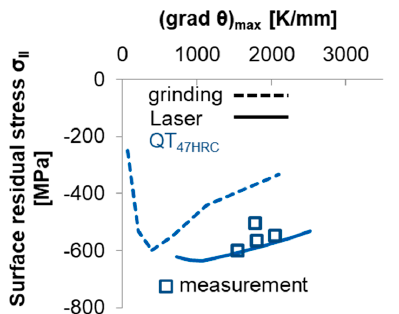
Figure 16. Residual stress on the surface. Simulation study for grind and laser hardening and comparison with measured data for laser hardening.